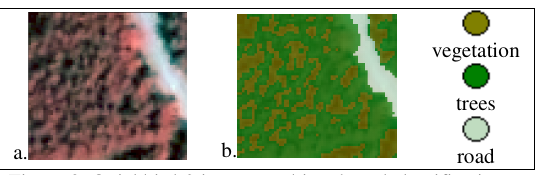
Figure 3. Quickbird-2 imagery, object-based classification results for plot number = 3, stand number = 6.